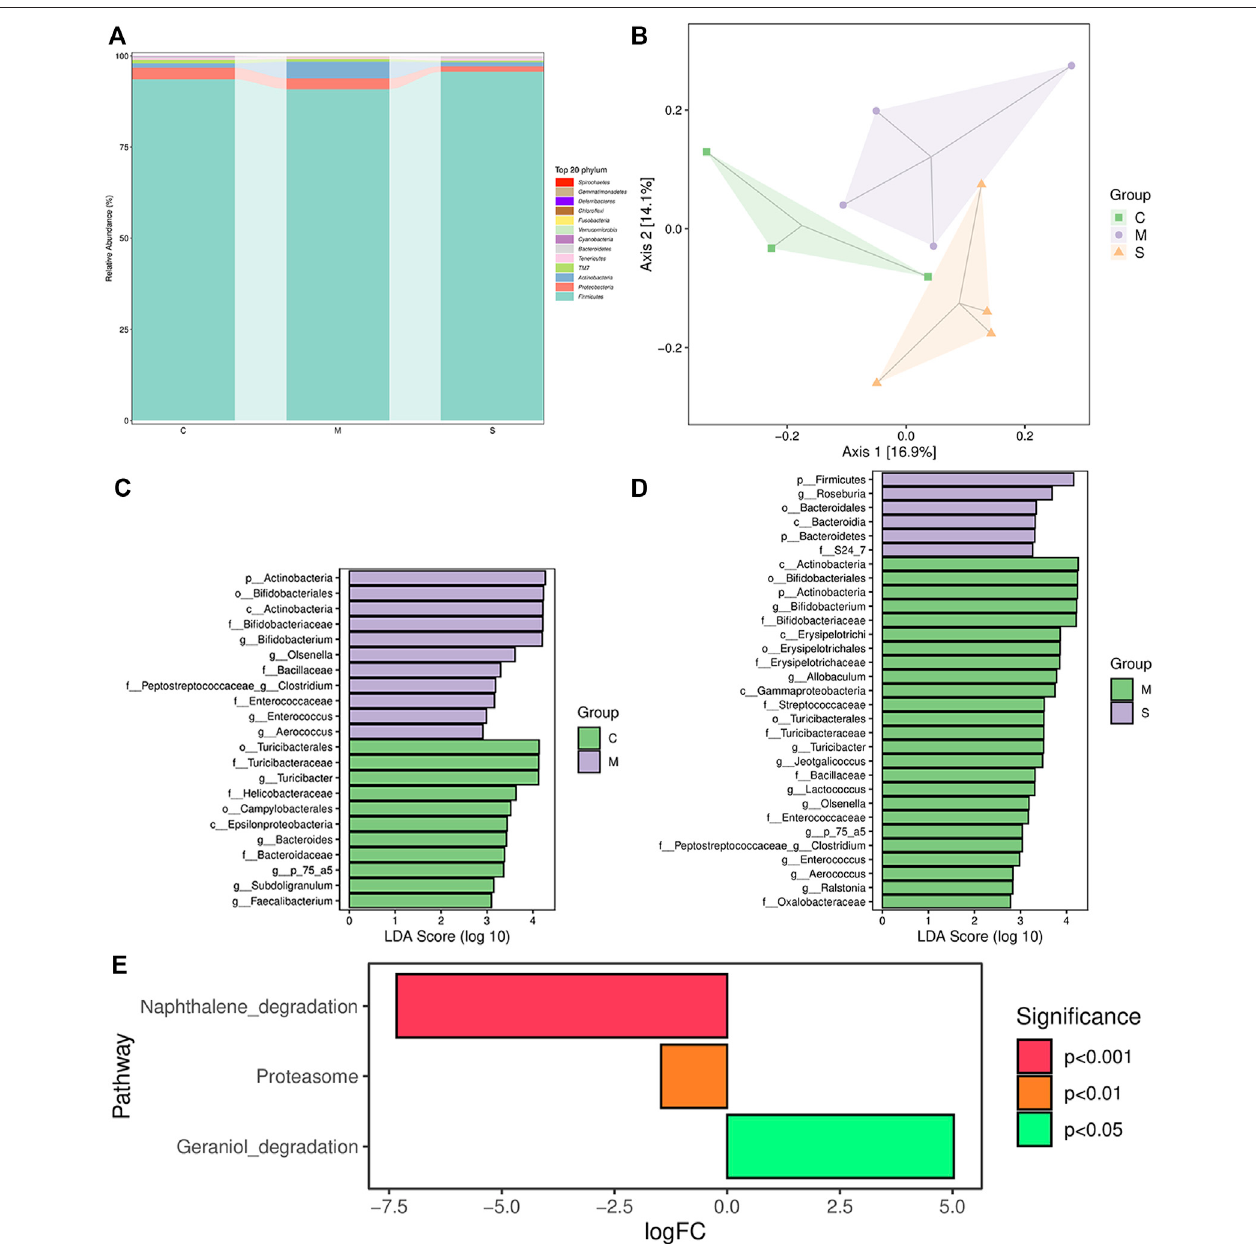
FIGURE5| Resultsof16SrRNAsequenceanalysis. (A) Overviewofthegutmicrobialcompositionofthenormalcontrolgroups,modelgroups,andSHLmedium- dose groups at the phylum level. (B) PCoA of gut microbiota in the normal control groups and model groups. (C) LDA histogram of the normal control groups and in fl ammatory model groups. (D) LDA histogram ofSHLmedium-dosegroupsand in fl ammatorymodelrats. (E) MetagenomeseqanalysisofKEGG differential metabolic pathways, comparison between SHL medium-dose groups and in fl ammation model groups.